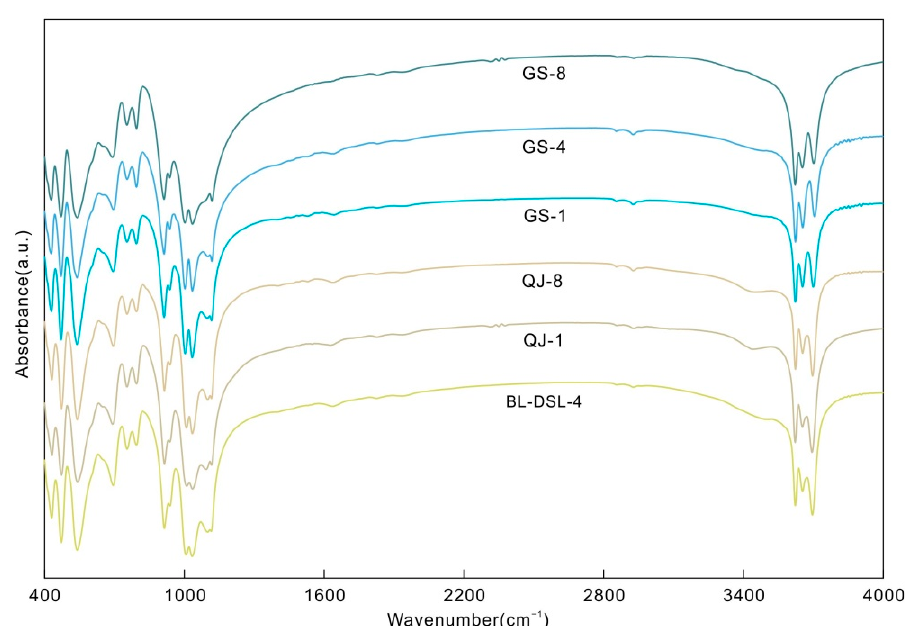
Figure 2. MIR spectra of the kaolinite and dickite samples.